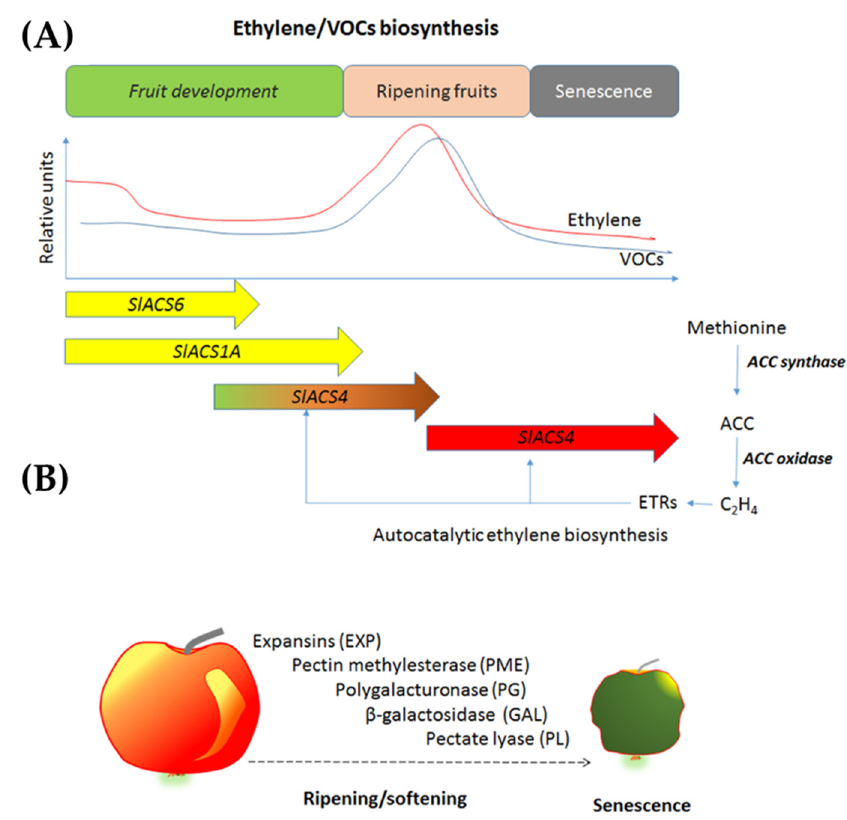
Figure 11. ( A ) Schematic and simplified biosynthesis of ethylene and VOCs in fruit development. VOCs biosynthesis originate from different pathways, for example phenylpropanoids, fatty acid, and carotenoids degradation. ( B ) The main enzymes participating in cell wall degradation during fruit ripening and senescence, reproduced from [92].